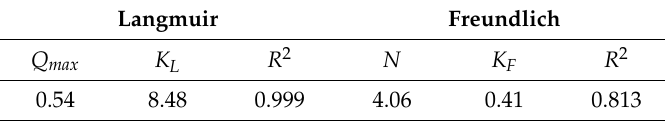
Table 3. Comparison of lead ion adsorption with some reported